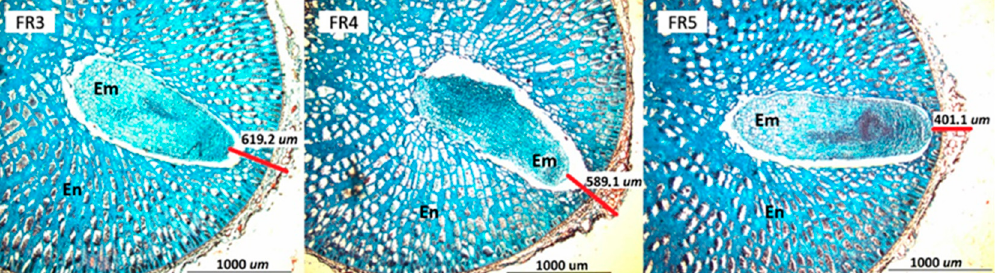
Figure 8. Histological cross section of A. pelegrina seeds at different maturity stages of fruits. FR3: Fruit stage 3; FR4: Fruit stage 4; FR5: Fruit stage 5; Em: embryo; En: endosperm. Red bars represent the distance between the position of the embryo and the apical zone of the seed. Scale bar: 1000 um.